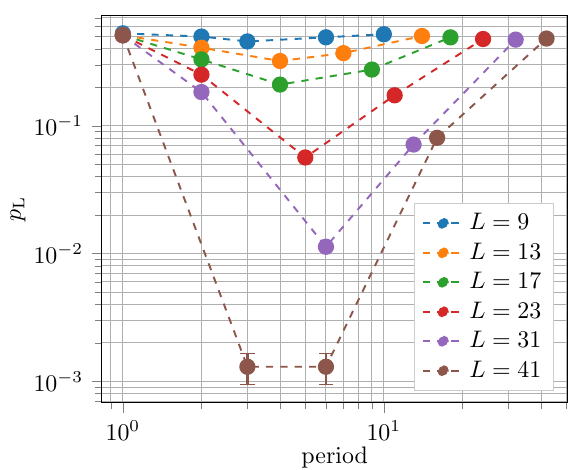
Figure 5. Optimizing the direction-change frequency for the sweep decoder applied to the toric code on the rhombic dodecahedral lattice (with boundaries). We plot the logical error rate p L as a function of the direction- change period for various values of L . The number of error correction cycles is N = 2 10 and p = q = 0.021 . We achieve the best performance when we change sweep direction every ∼ log L cycles. We use 10 4 samples for each